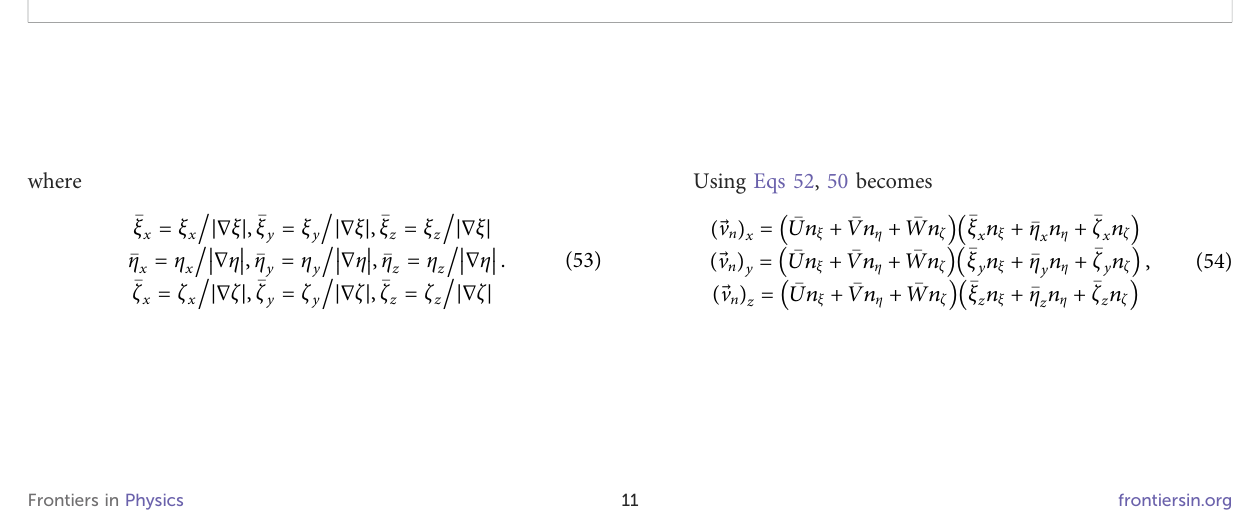
FIGURE 4 (A) Mach distribution with P 1 Q 1 element on0.4,0.2,0.1and0.05 meshsizeform leftto rightand fromtopto bottom. (B) Machdistributionwith P Q 1 2 element on 0.4, 0.2, 0.1 and 0.05 mesh size form left to right and from top to bottom. (C) Mach distribution with 0.1and0.05meshsizeformlefttorightandfromtoptobottom. (D) Machdistributionwith P 3 Q 2 elementon0.4,0.2,0.1and0.05meshsizeformleft to right and from top to